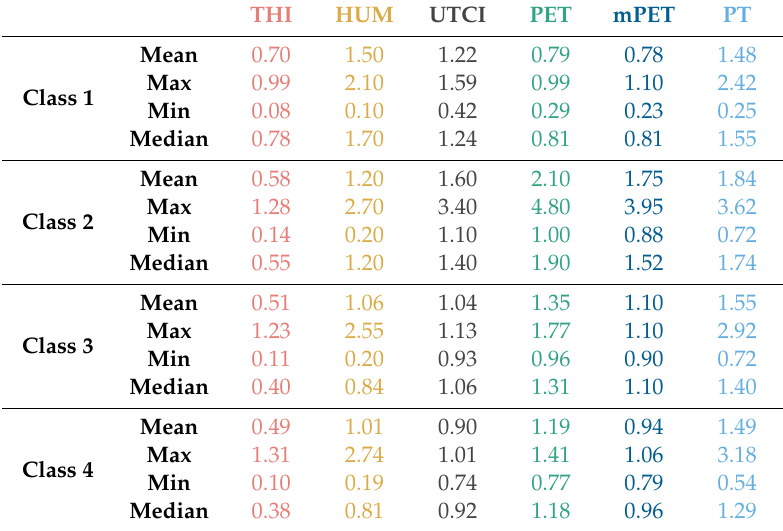
Table 11. Descriptive statistics of the indices’ sensitivity to VP change rates under di ff erent GR conditions.